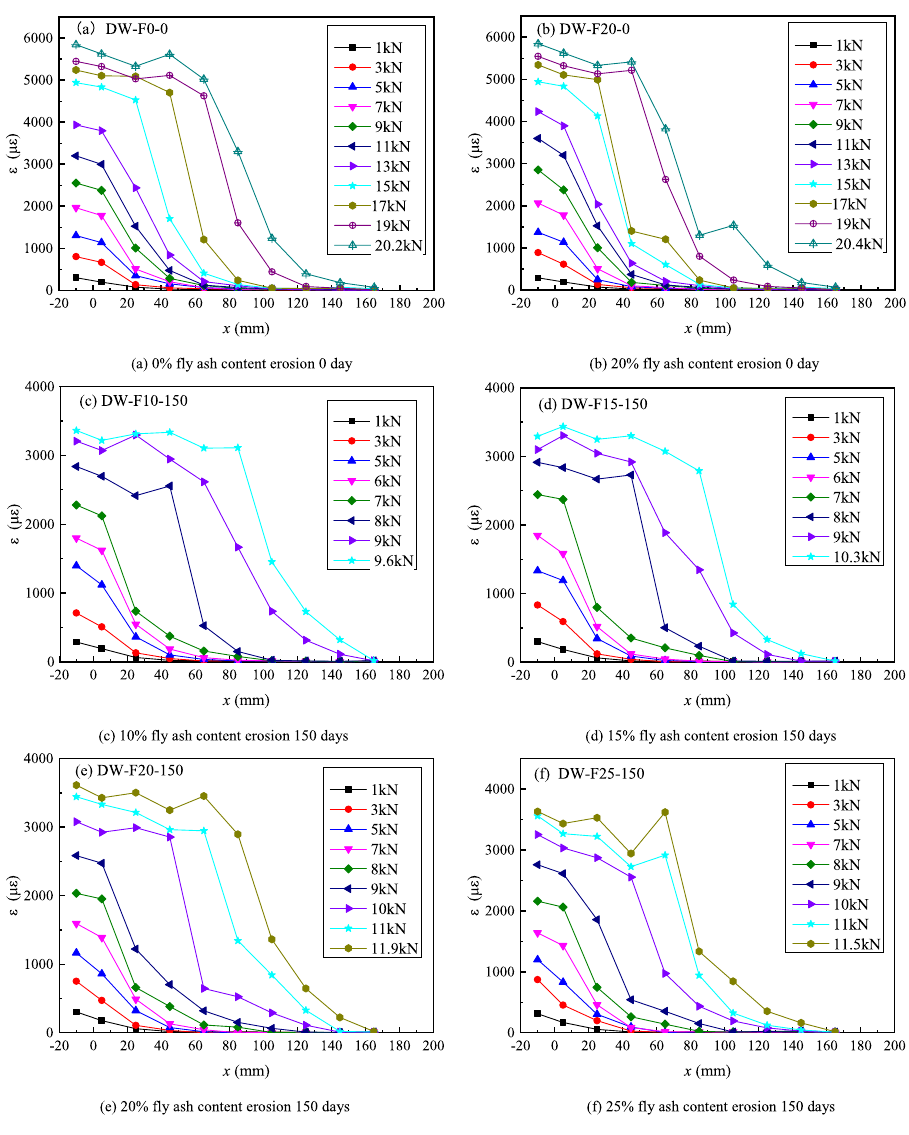
Figure 7. FRP strain distribution of various specimens under different loading